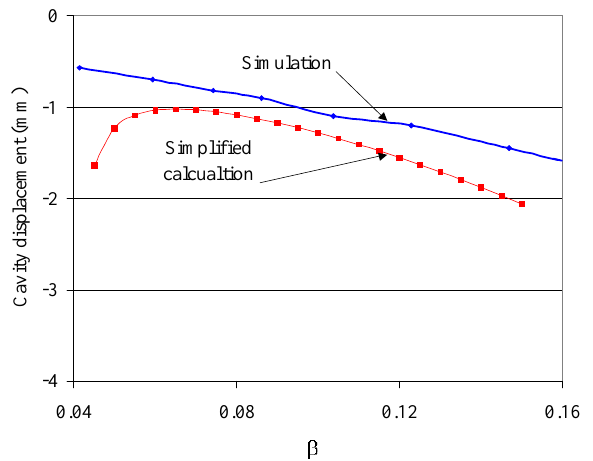
FIG. 7. (Color) A displacement of the 57.5 MHz QWR needed for compensation of the steering. The red line corresponds to the calculations based on Eqs. (6)–(8), and the blue curve is based on the TRACK code.